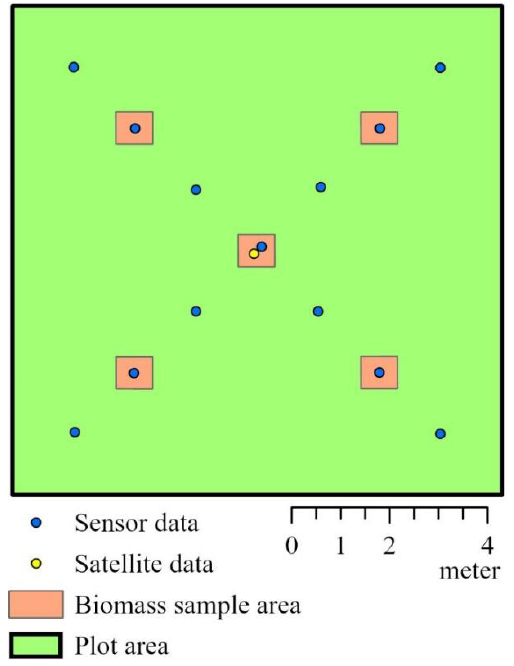
Figure 2. Structure and data distribution in the